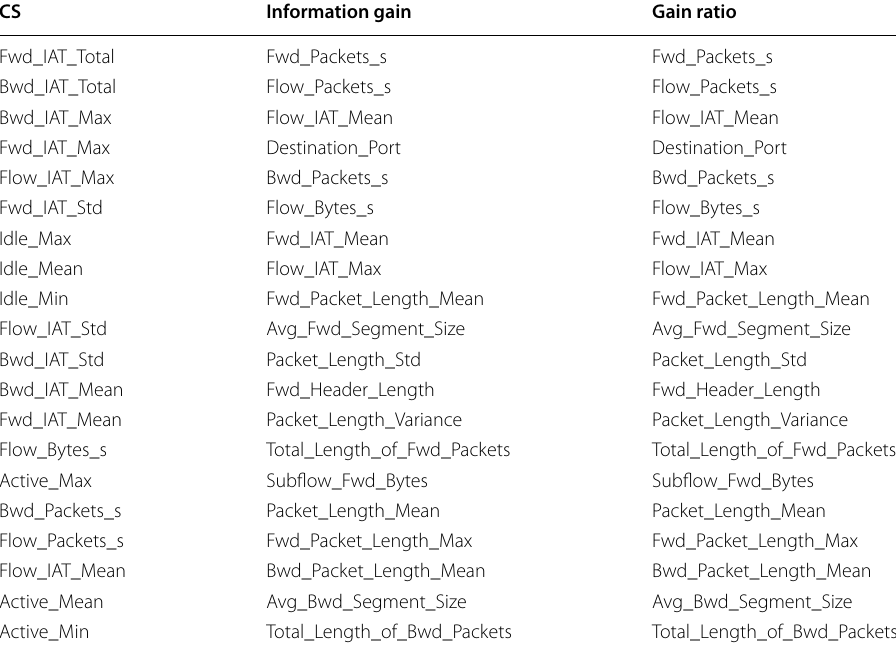
Table 2 Top 20 features by filter-based ranking technique for CSE-CIC-IDS2018 CS Information gain Gain